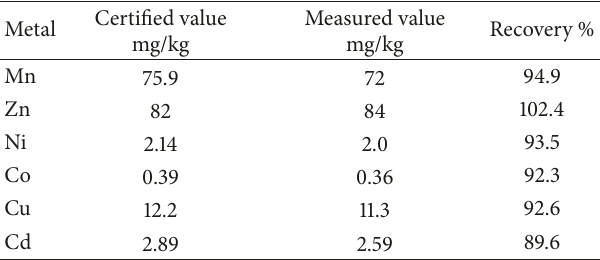
Table 2: Concentrations of selected elements in the NIST1570a certified reference